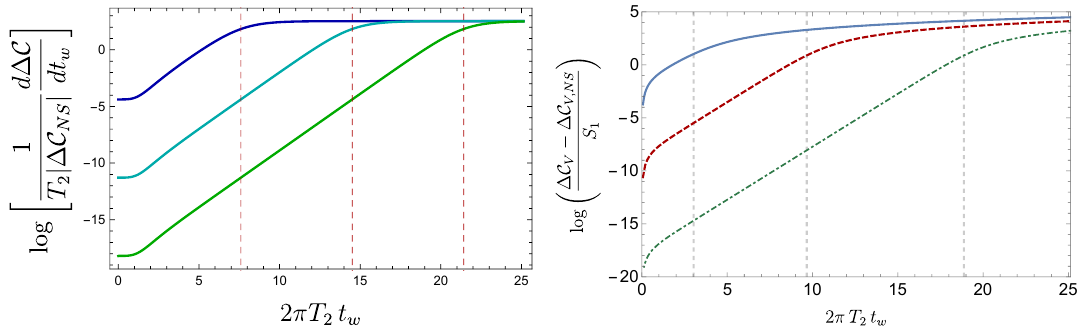
Figure 27. Left: the derivative of the complexity of formation for BTZ black holes using the CA conjecture with respect to the insertion time t w , for light shock waves characterized by w = 1+10 (cid:0) 3 (dark blue), w = 1+10 (cid:0) 6 (light blue) and w = 1+10 (cid:0) 9 (green). We observe a period of exponential growth until times of the order of the scrambling time, which then becomes a linear growth at late times where the plot saturates. Right: early exponential dependence of the complexity of formation on the injection time t w from the CV conjecture with w = 1+10 (cid:0) 1 (blue), w = 1+10 (cid:0) 4 (red dashed) and w = 1+10 (cid:0) 8 (green, dot-dashed). We can read from this plot the correct Lyapunov